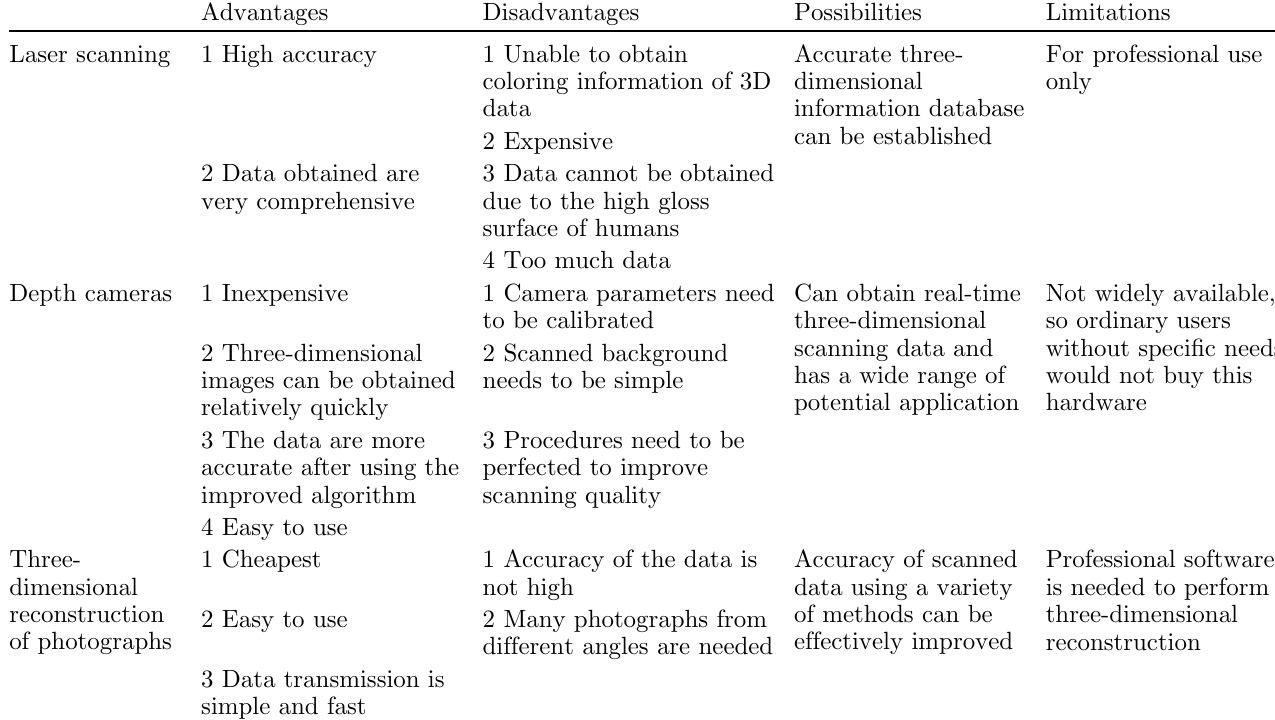
Table 1. Comparison of three methods used to obtain human